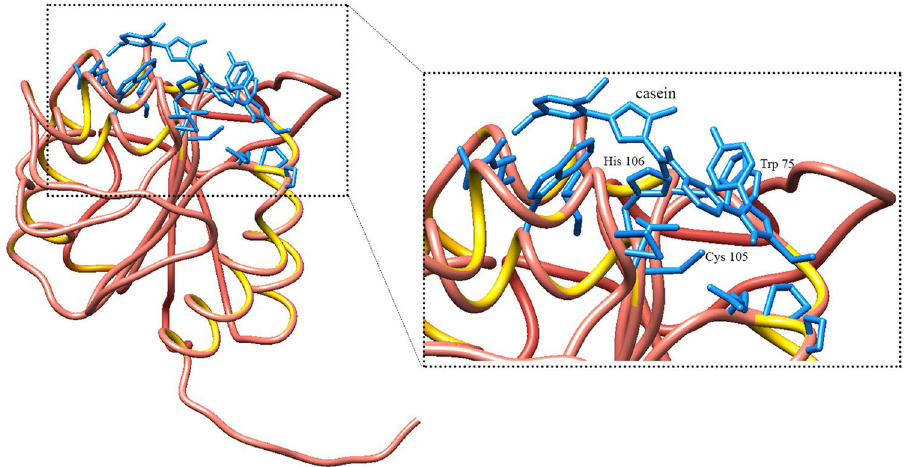
Figure 4. Predicted binding site of cysteine protease in interaction with casein as ligand. Cys 105, His 106, Gly 74 and Trp 75 are predicted catalytic residues.